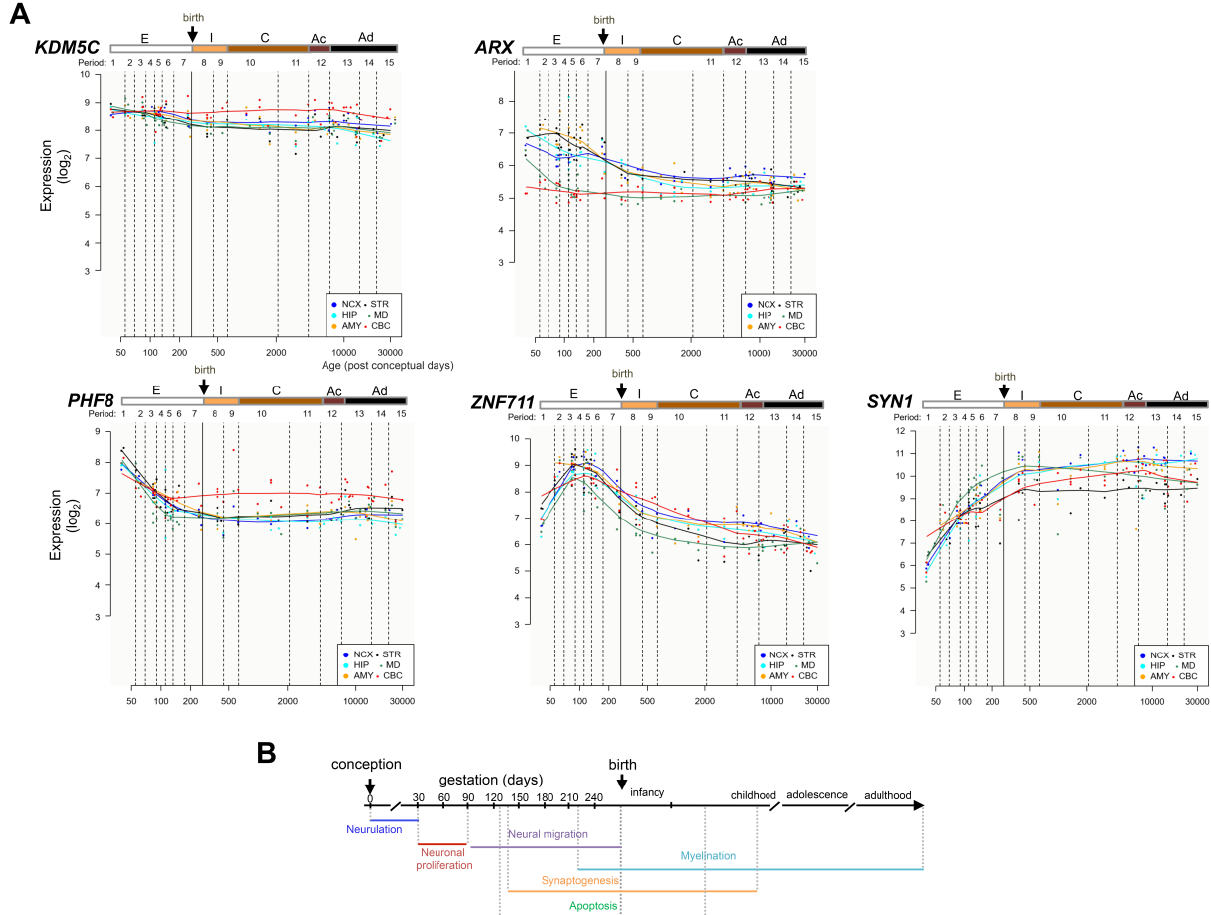
Figure 1. Expression profiles of KDM5C , ARX , PHF8 , and ZNF711 during development and in the adult human brain. ( A ) Data from Human Brain Transcriptome Atlas are shown in RPKM. Original images can be accessed freely at https: //hbatlas.org/hbtd/basicSearch.pl (accessed on 2 April 2021). Period 1, 4 < Age < 8 postconceptional weeks (PCW); Period 2, 8 < Age < 10 PCW; Period 3, 10 < Age < 13 PCW; Period 4, 13 < Age < 16 PCW; Period 5, 16 < Age < 19 PCW; Period 6, 19 < Age < 24 PCW; Period 7, 24 < Age < 38 PCW; Period 8, Neonatal and early infancy, birth ≤ Age < 6 postnatal months; Period 9, Late infancy, 6 < Age < 12 postnatal months; Period 10, Early childhood, 1 < Age < 6 years; Period 11, Middle and late childhood, 6 < Age < 12 years; Period 12, Adolescence, 12 < Age < 20 years; Period 13, Young adulthood, 20 < Age < 40 years; Period 14, Middle adulthood, 40 < Age < 60 years; Period 15, Late adulthood, 60 + years [35]. Embryonic development (E), from 1 to 7; birth and infancy (I), from 8 to 9; childhood (C), from 10 to 11; adolescence (Ac), 12; adulthood (Ad), from 13 to 15. Brain regions: neocortex (NCX), hippocampal formation (HIP), amygdala (AMY), striatum (STR), midbrain (MB), cerebellum (CBC). ( B ) A glimpse of developmental-stage-specific chronology for neurogenesis (from the embryonic life to the adult stage in